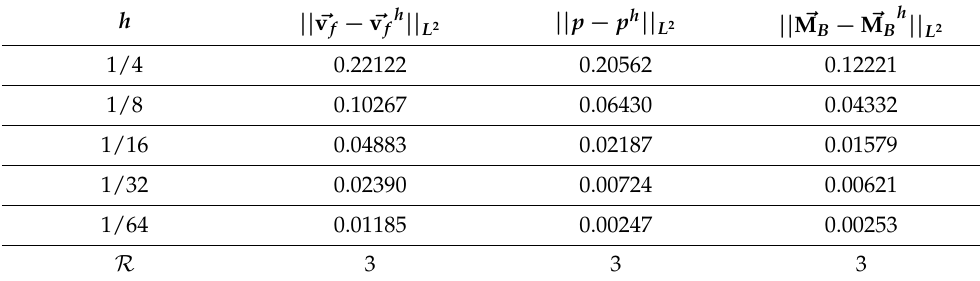
Table 1. The error estimate for MHD with standard FE P 1 b − P 2 − P 1 pair.